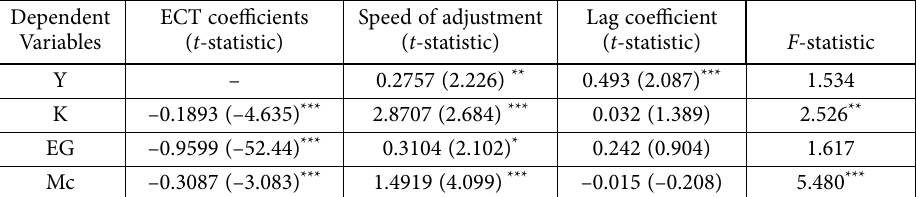
Table 3. Estimation of Error-Correction-Term in the Vector Error-Correction Model (source: authors’ own processing)